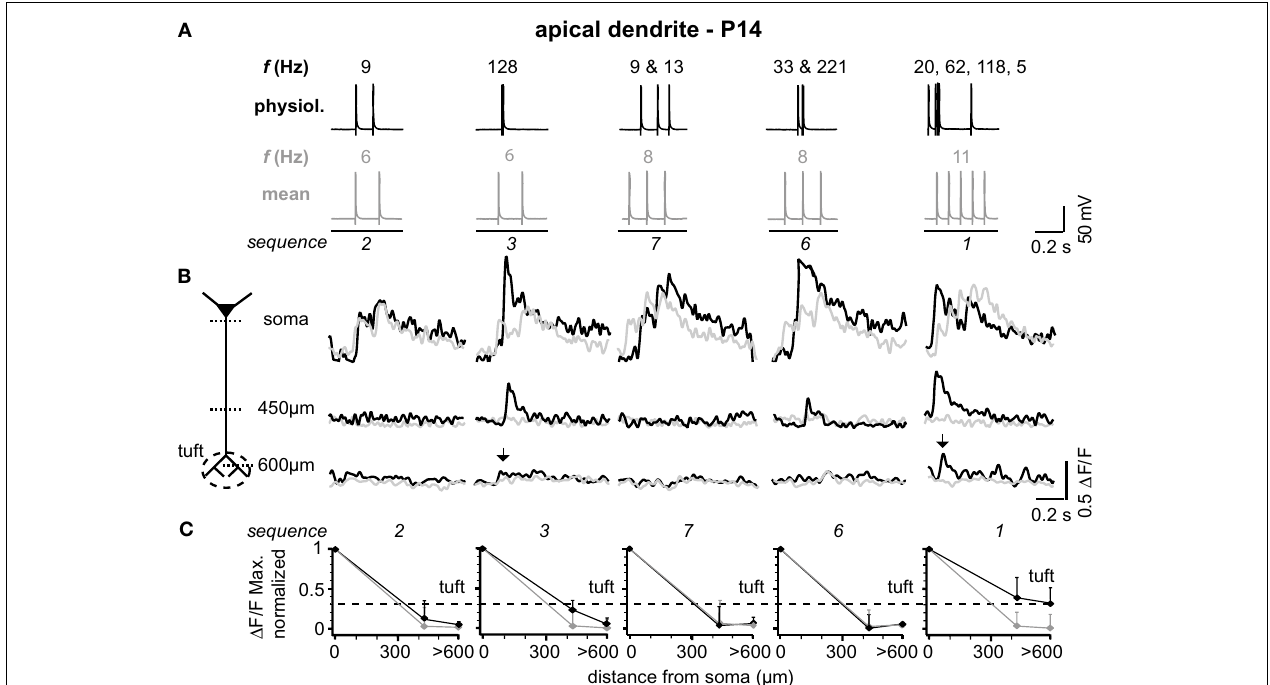
FIGURE 5 | Backpropagation of physiological fi ring patterns into the apical dendrites at P14. (A) Five (out of ten tested) different natural fi ring patterns (black traces) and the corresponding mean fi ring patterns (gray traces) were evoked by somatic current injection in a layer 5A pyramidal neuron at P14. Frequencies within the AP trains are given above and the sequence numbers below the traces. (B) Ca 2 + transients elicited by these AP sequences were measured at the soma, 450 µm from soma, and 650 µm from soma (tuft region) across the apical dendritic arbor (see schematic). Note that only AP sequences containing high-frequency components (arrows) back-propagate into the distal